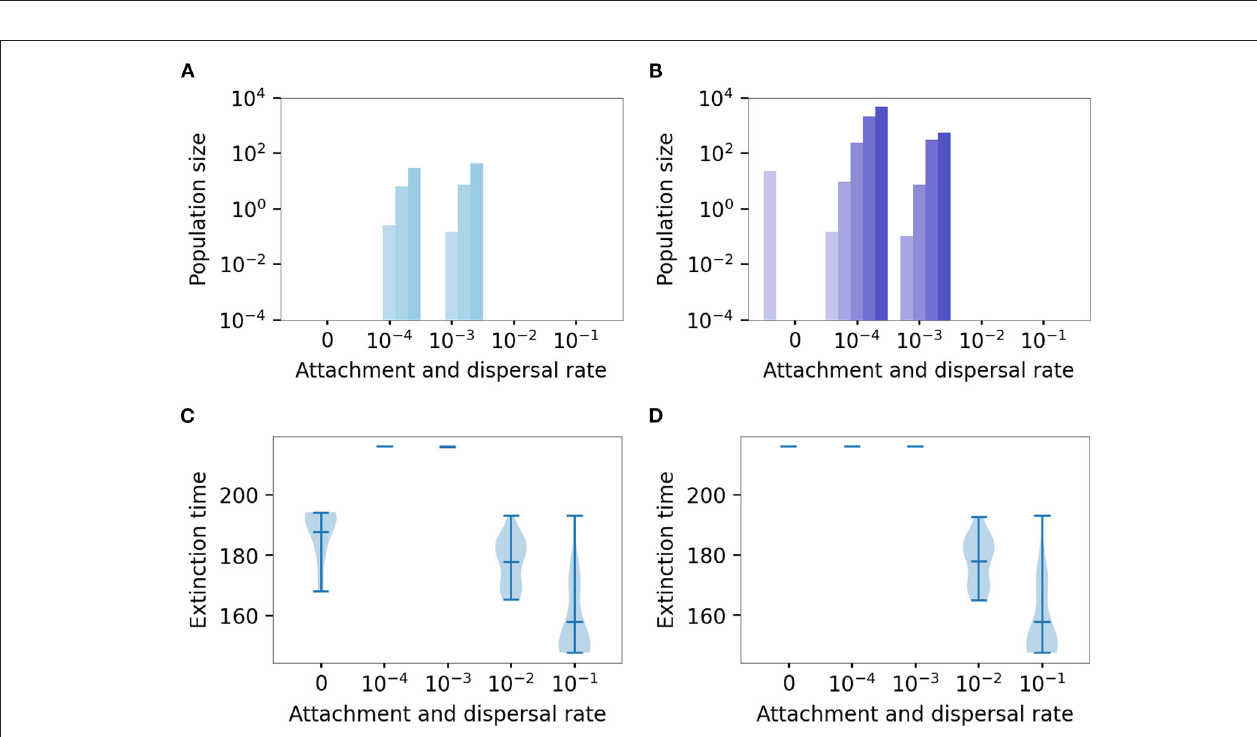
FIGURE 8 | Effect of continuous attachment and dispersal on genetic composition and survival time. Genetic composition of the final populations that survived the passage experiment, in plankton (A) and biofilm (B) , where both physical, and physiological recalcitrance mechanisms were considered. The bars are colored blue (plankton) and purple (biofilm) in accordance with Figure 7 . The degree of shading of the bars denotes subpopulations with a different number of mutations: lightest for wild type, darkest for the full (quadruple) mutant. Mean sizes across 20 simulations. Distribution of extinction times of plankton (C) and biofilm (D) .